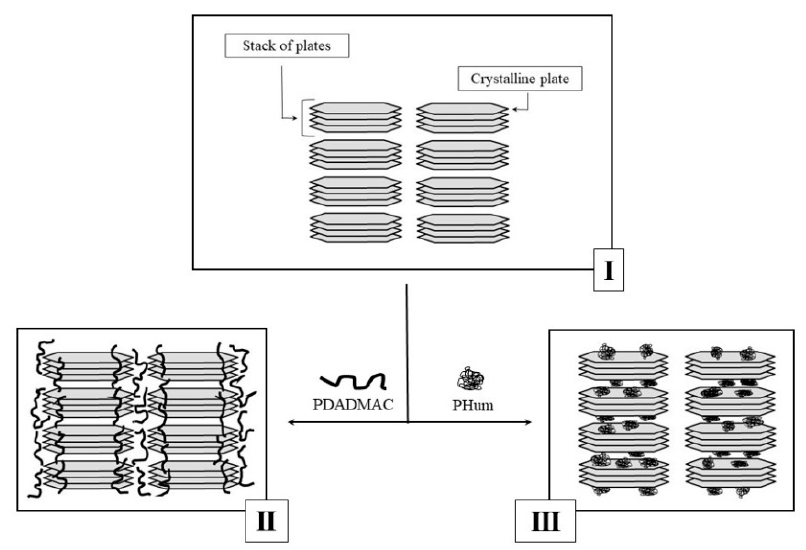
Figure 3. Schematic representation of the structure of virgin kaolinite ( I ), kaolinite–PDADMAC ( II ) and kaolinite–PHum samples ( III ).